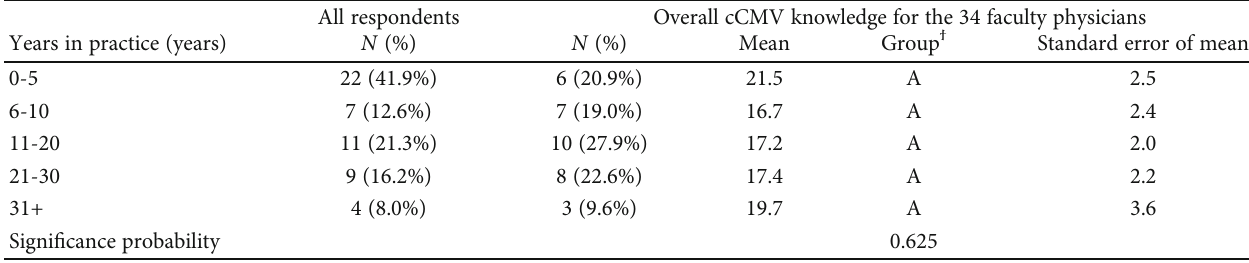
Table 2: Baseline respondent years in practice and faculty physician cCMV knowledge scores.